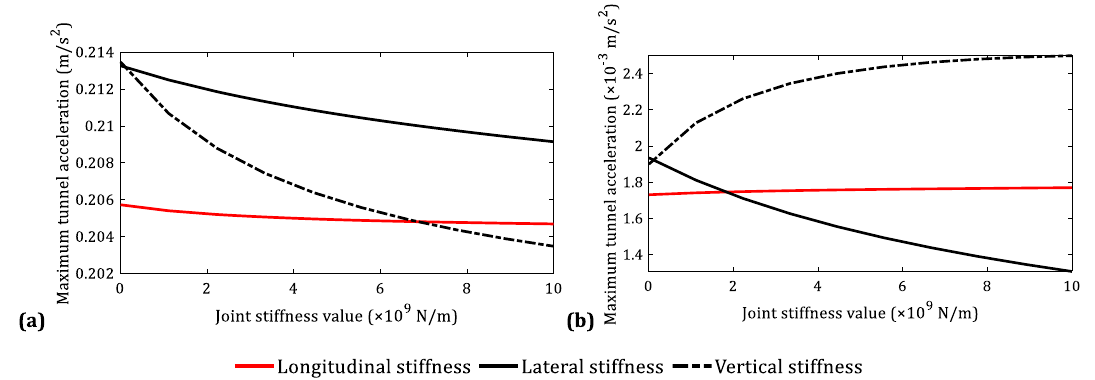
Fig. 18 Influence of tunnel segmental joint stiffness on tunnel vertical acceleration: a tunnel bottom segment; b tunnel